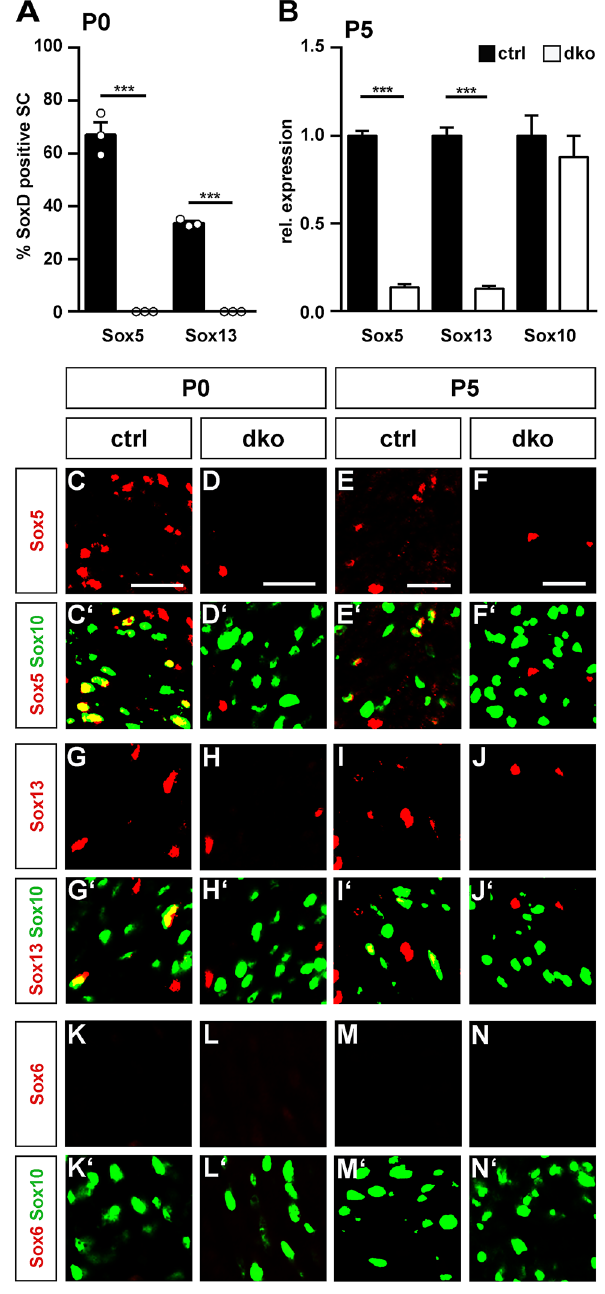
Figure 2. Analysis of SoxD deletion in Schwann cells of dko mice. ( A ) Quantification of the percentage of SoxD-positive Schwann cells at P0 in sciatic nerves of control (black bars) and dko (white bars) mice (n = 3; mean values ± SEM). ( B ) Quantification of the amount of Sox5 , Sox13 and Sox10 transcripts in sciatic nerves of control and dko mice at P5 (n = 6) by qRT-PCR. Transcript levels in controls were set to 1 for each gene, those for dko mice expressed relative to it (± SEM). Statistical significance was determined by unpaired, two-tailed Student’s t-test (***P ≤ 0.001). For p-, t- and df-values, see Supplementary Fig. S3. ( C–N ) Co-immunohistochemistry was used to determine expression of Sox5 ( C–F ), Sox13 ( G–J ) and Sox6 ( K–N ) (all in red) in Sox10-positive Schwann cells ( C ′ – N ′ , in green) of sciatic nerves of control ( C,C ′ ,E,E ′ ,G,G ′ ,I,I ′ ,K,K ′ , M,M ′ ) and dko ( D,D ′ ,F,F ′ ,H,H ′ ,J,J ′ ,L,L ′ ,N,N ′ ) mice at P0 ( C,C ′ ,D,D ′ ,G,G ′ ,H,H ′ ,K,K ′ ,L,L ′ ) and P5 ( E,E ′ ,F,F ′ ,I ,I ′ ,J,J ′ ,M,M ′ ,N,N ′ ). Orientation of nerves and magnified area were as shown in Fig. 1C,D. Scale bar, 25